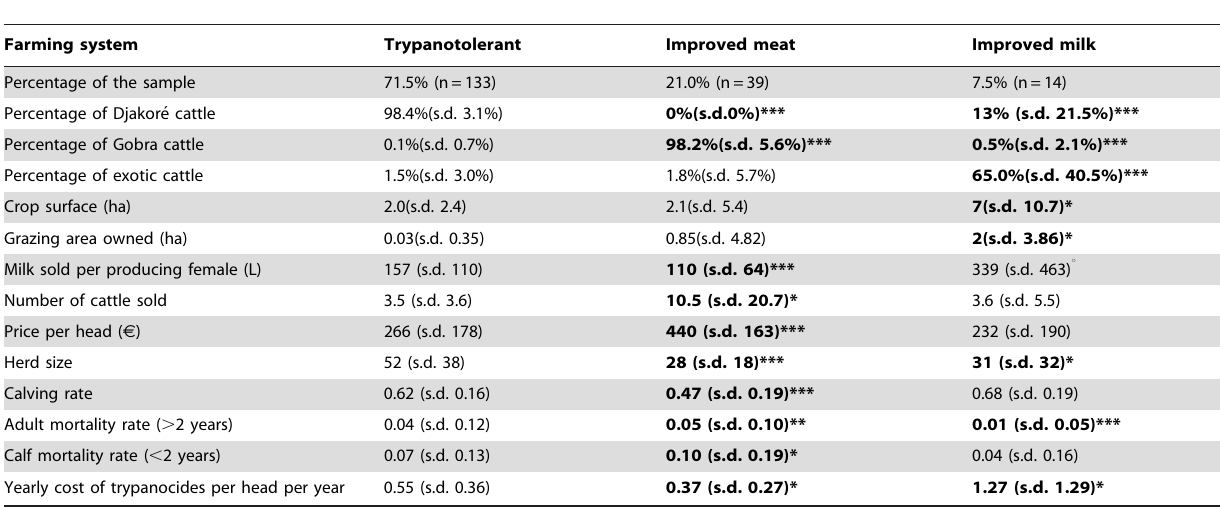
Figure 4. Boxplots of cattle herd size and annual sales of improved and trypanotolerant cattle. Annual sales correspond to the total sales divided by the number of cattle present in the farm. doi:10.1371/journal.pntd.0003112.g004 Table 1. Description details of the three farming systems encountered in the